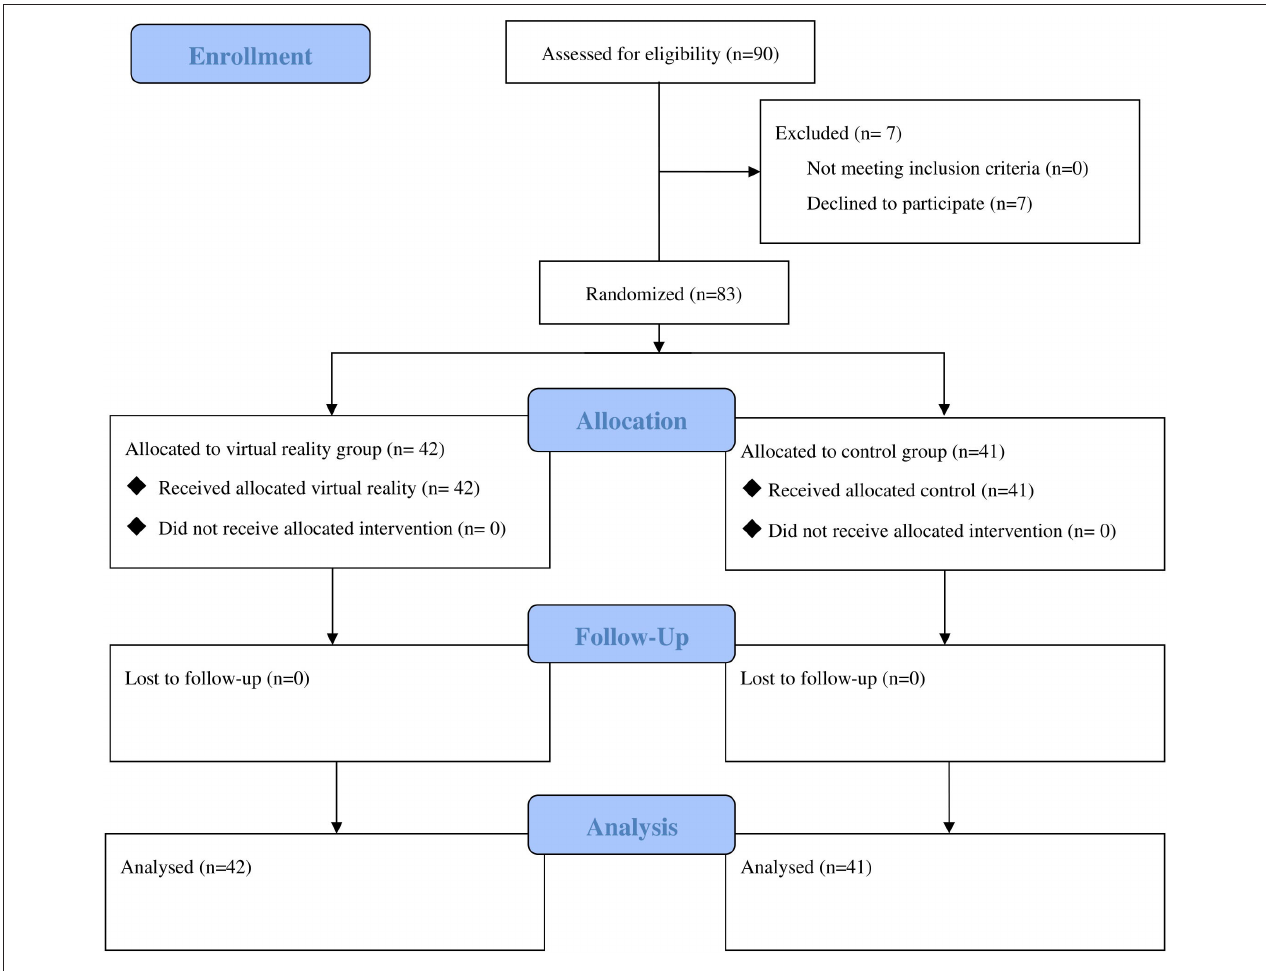
FIGURE 1 | CONSORT flow